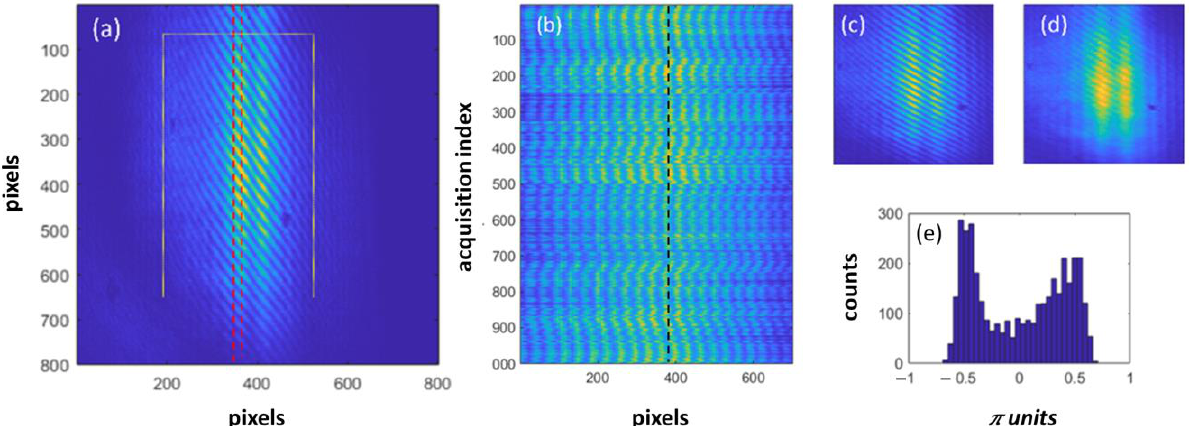
Figure 8. ( a ) Out-of-focus, single shot acquisition (at DiProI) at t 0 . ( b ) Stack of vertical profiles computed within the red region-of-interest of panel ( a ). Each profile deploys horizontally; black line: arbitrary reference. ( c , d ) Details of the yellow region-of-interest of panel ( a ) displaying a single shot and a numerically averaged image (over 3700 shots), respectively. ( e ) Histogram of the fringe displacement jitter, expressed in π units.